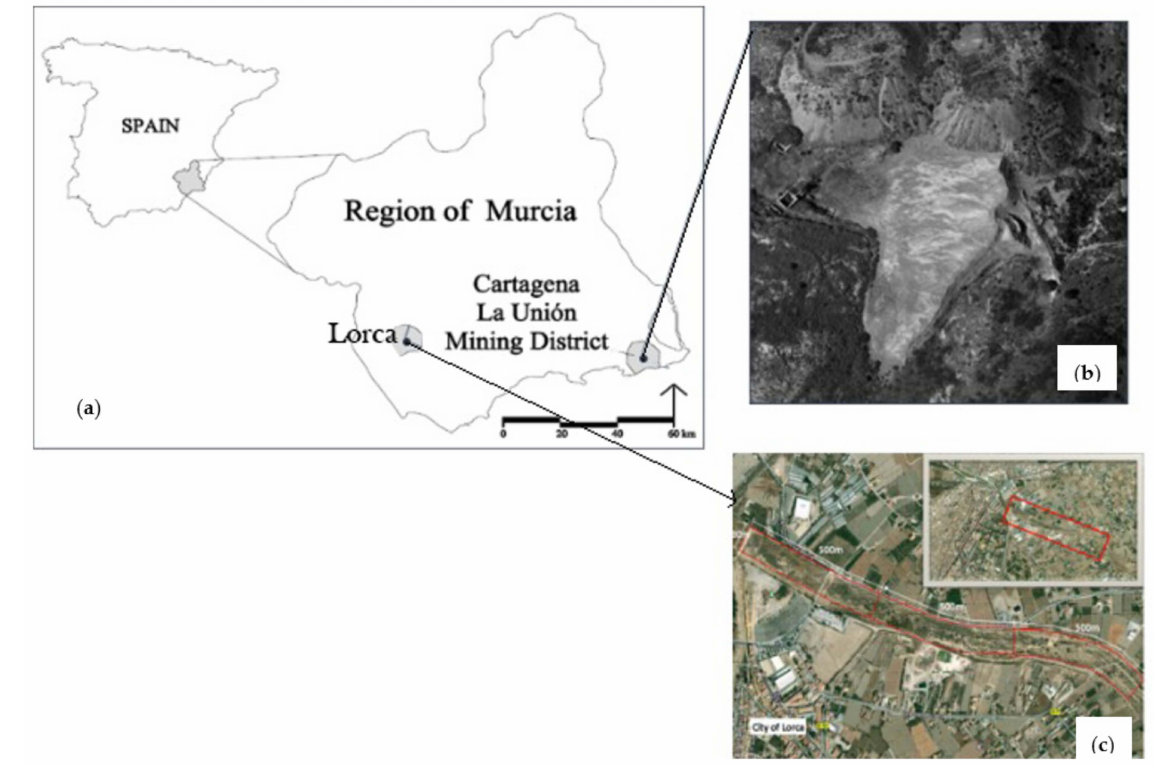
Figure 2. Situation of: ( a ) the Region of Murcia with location of the two case studies, and the case studies’ situation, ( b ) the Santa Antonieta mining deposit in Cartagena, and ( c ) section of the contaminated Guadalent í n river in